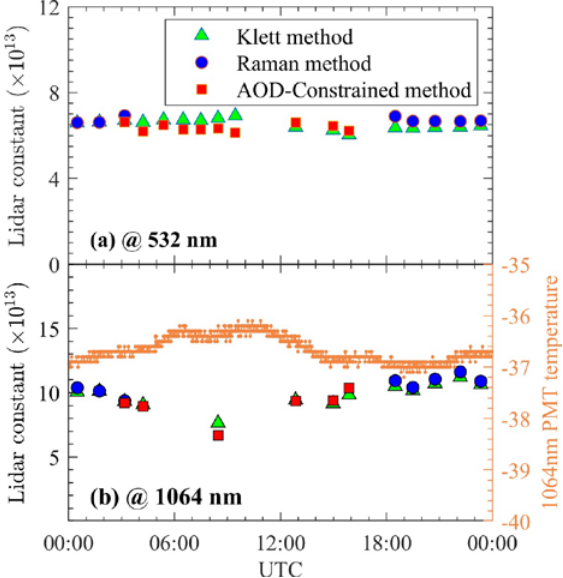
Figure 6. Time series of lidar constants at 532 nm (a) and 1064 nm (b) with Klett method, Raman method and AOD-Constrained method on 06 April 2017 at Limassol,